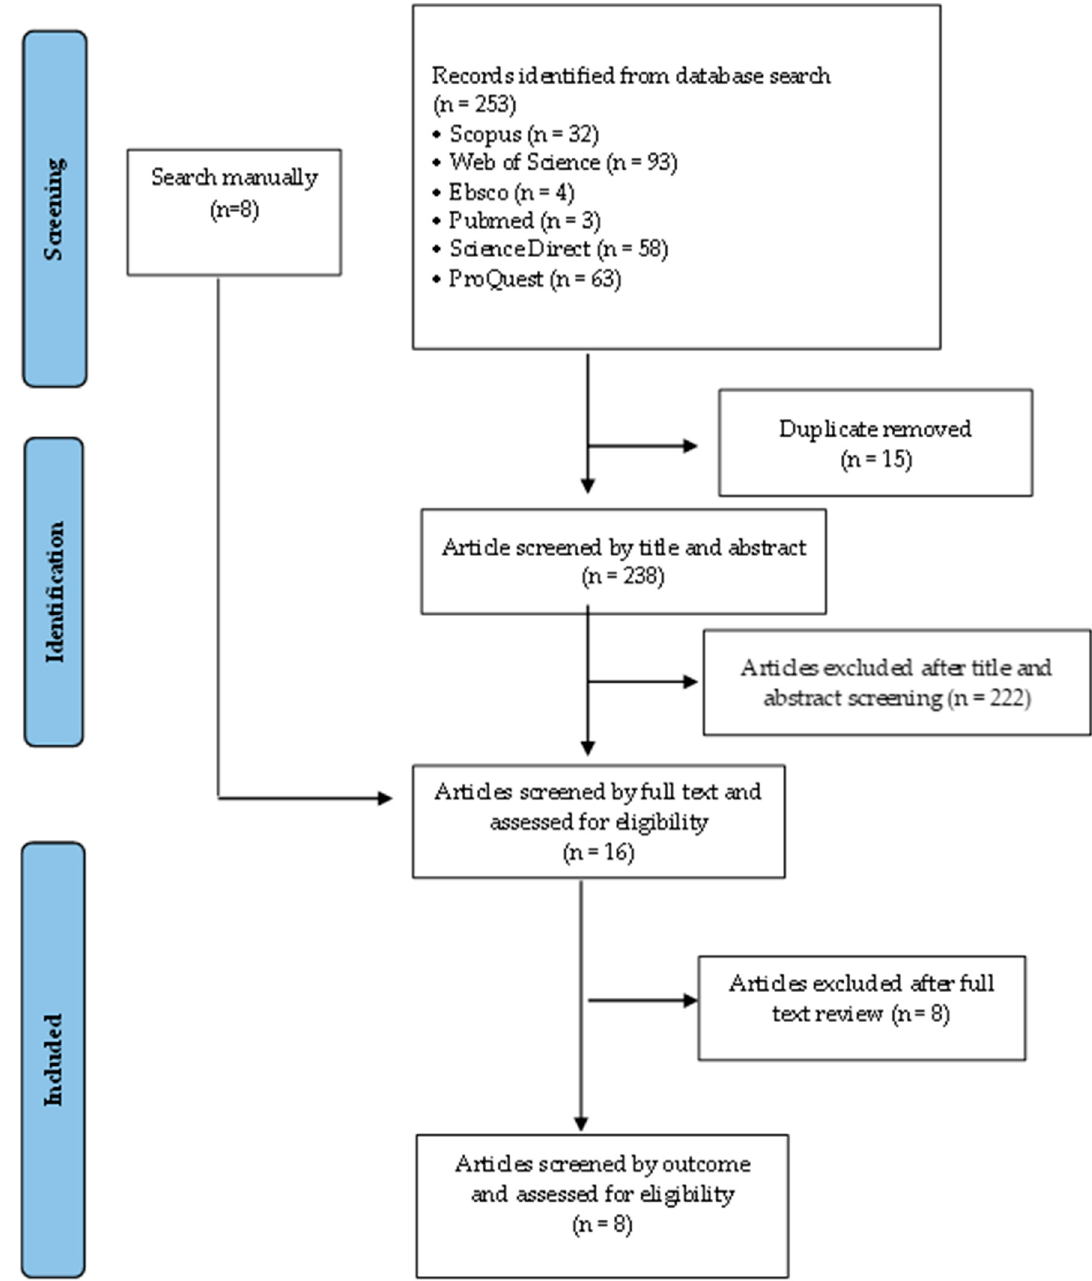
Figure 1. PRISMA fl ow diagram identi fi cation of articles included in systematic review and meta- analysis. Figure 1. PRISMA flow diagram identification of articles included in systematic review and